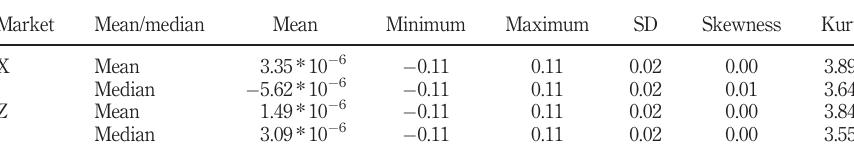
Table II. Descriptive statistics for asset returns of the two markets